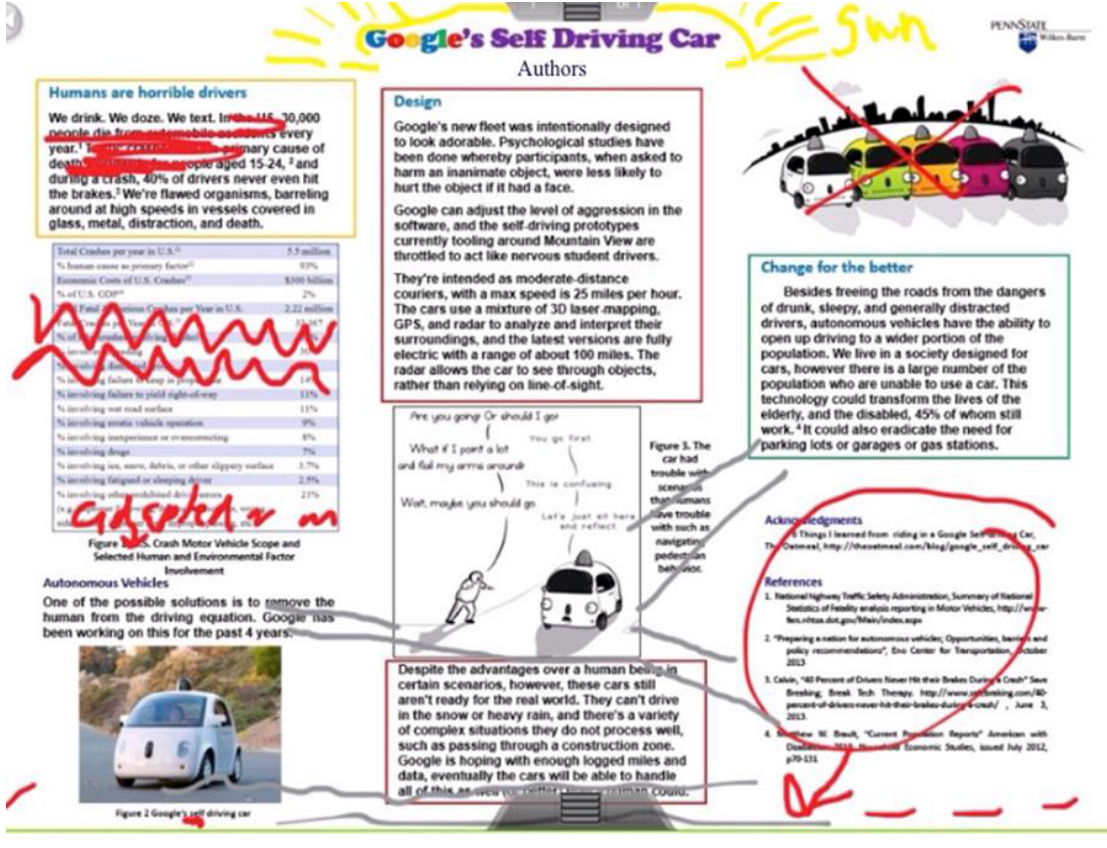
Draft of original “Google’s Self-Driving Car” poster with markup that illustrates editorial